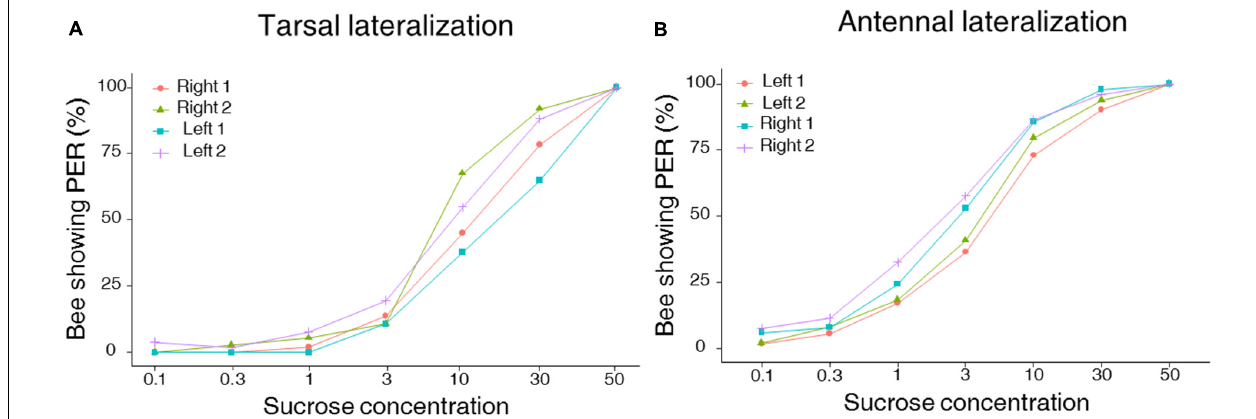
FIGURE 2 | Left–right tarsal (fore-tarsi) (A) and antennal (B) responsiveness to sucrose solution. Both graphs show cumulative percentages of bees showing PER when stimulated with seven sucrose solutions of increasing concentration (0.1, 0.3, 1, 3, 10, 30, and 50% w/w). Approximately half of the bees were tested first on the right antenna (Right 1) and then on the left antenna (Left 2) ( n = 49) and vice versa (Left 1 and Right 2) ( n = 52). Similarly, about half of the bees were tested first on the right tarsus (Right 1) and then on the left tarsus (Left 2) ( n = 51) and vice versa (Left 1 and Right 2) ( n = 37). (A) No lateralization of tarsal sucrose sensitivity was found (GLMM, p = 0.10), but a significant effect of the stimulation sequence was detected (GLMM, p = 0.014), with sensitivity being increased during the second stimulation phase. (B) A lateralization of antennal sucrose sensitivity was found at the population level, with the right antenna being significantly more sensitive to sucrose than the left one (GLMM, p < 0.0001).